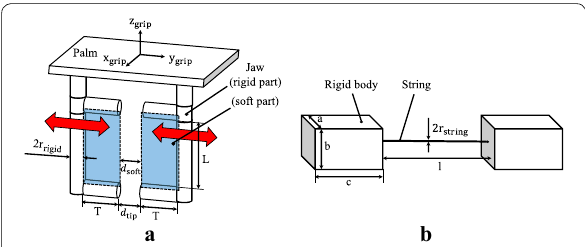
Fig. 15 Two rigid bodies connected with a string. a Hand and b object model